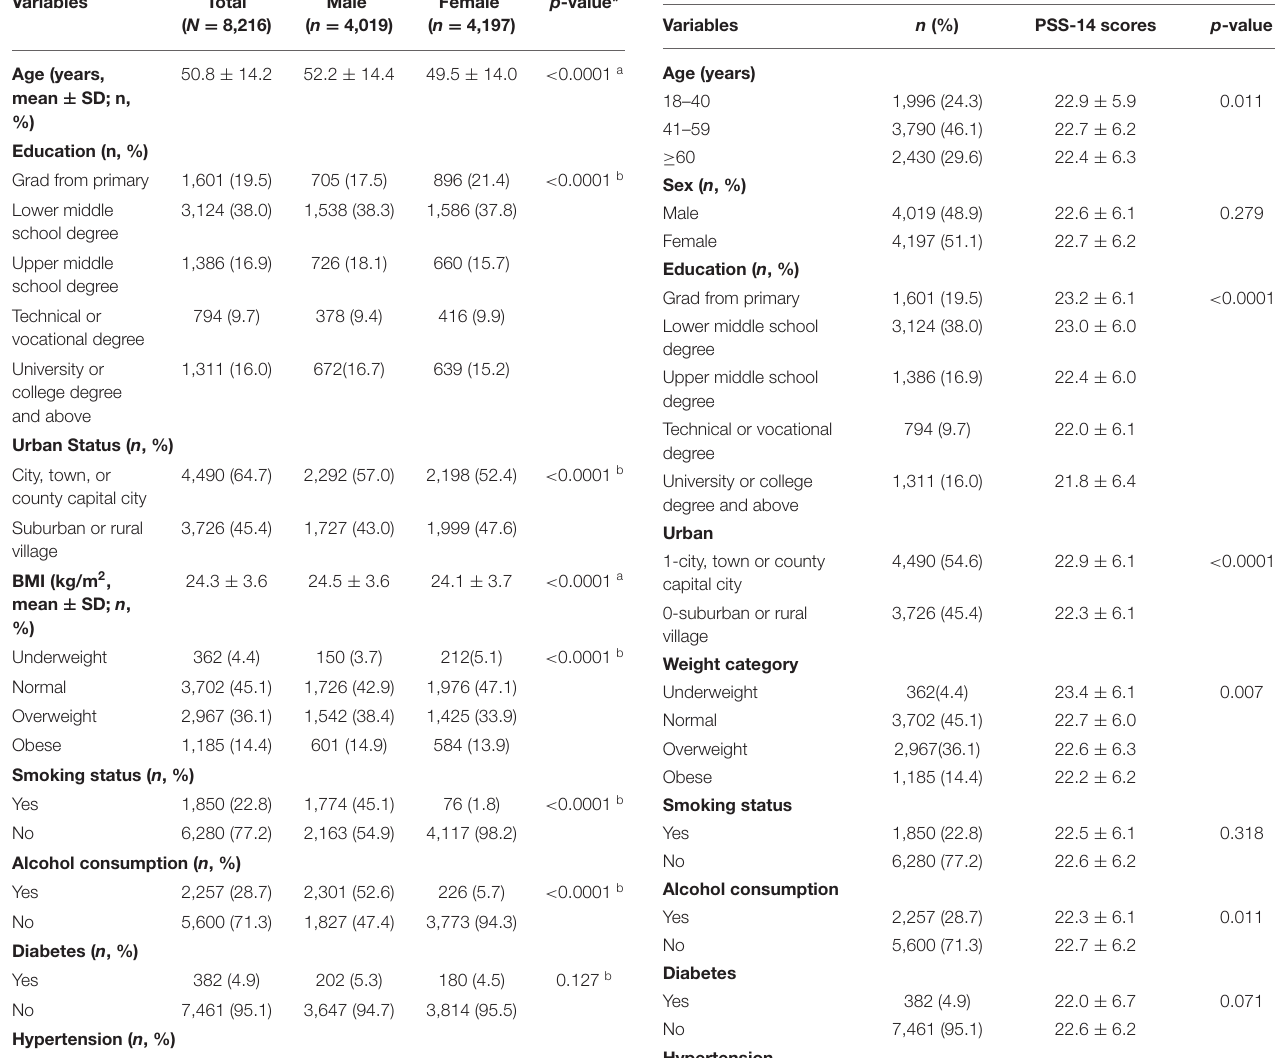
of participants. Variables